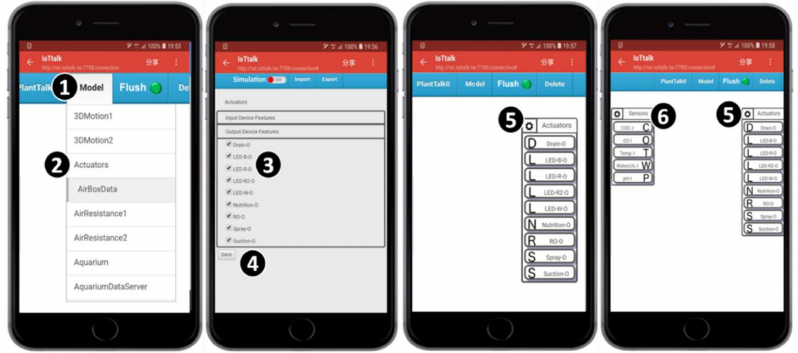
Figure 4. Configuring a PlantTalk